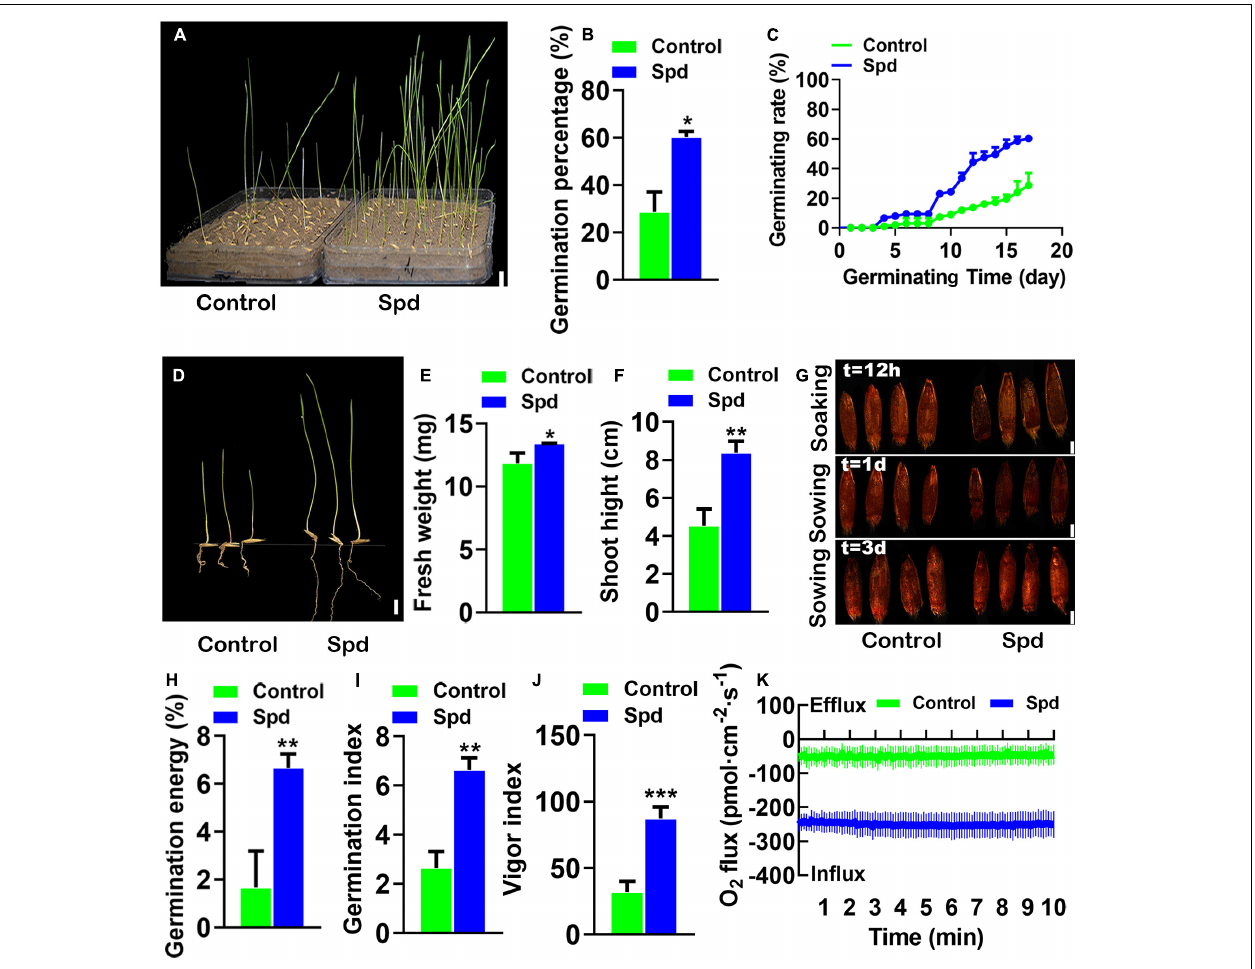
FIGURE 2 | The vigor of the germinating Leymus chinensis seeds under salt-alkali stress. (A) Germination phenotype of 17 days. (B) Germination rates of seeds. (C) Time course of seed germination at 25 ◦ C. (D) The seedling phenotype of 17-day old, bar = 1 cm. (E) Fresh weight of 17-day-old seedlings. (F) Shoot height of 17-day-old seedlings. (G) The seed vigor, bar = 0.1 cm. (H) Germination energy. (I) Germination index. (J) Vigor index. (K) Transient net O 2 flux kinetics. Vertical bars indicate mean ± SD ( n = 3), and * or ** or *** indicates a significant difference at the level of p < 0.05 or at the level of p < 0.01 or at the level of p < 0.001,